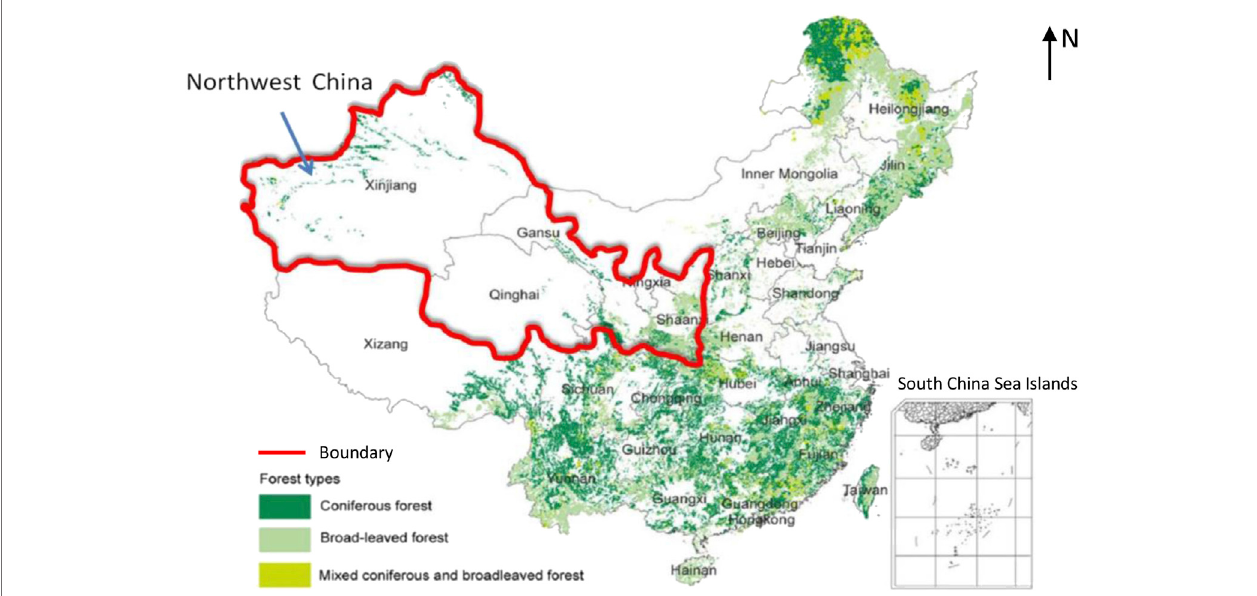
FIGURE 1 | Forest distribution in Northwest China based on the data of the sixth forest inventory (1999 – 2003). Forests are grouped into three types: coniferous forest,broad-leavedforest,andconiferousandbroad-leavedmixedforest.ThebackgroundmapshowstheadministrativedivisionsofChina.doi:10.1371/journal.pone. 0020778.g001.